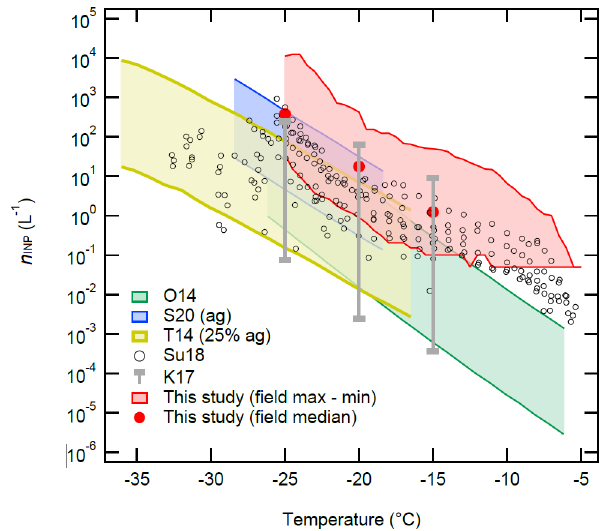
Figure 9. The n INP (T ) spectra of soil dust and aerosol parti- cles as a function of temperature. The red-shaded area repre- sents the range of our field n INP values at 0.5 ◦ C intervals for − 5 ◦ C > temperature > − 25 ◦ C from this study (Fig. 6). The red solid symbols are our medians at − 15, − 20, and − 25 ◦ C. Five ref- erence data are adapted from O’Sullivan et al. (2014 Fig. 9; O14), Steinke et al. (2020 Fig. 3; S20), Tobo et al. (2014 Fig. 6b; T14), Suski et al. (2018 Fig. 1a–d; Su18), and Kanji et al. (2017 Figs. 1– 10; K17). Note that we display the maximum and minimum at − 15, − 20, and − 25 ◦ C of K17 in comparison to our